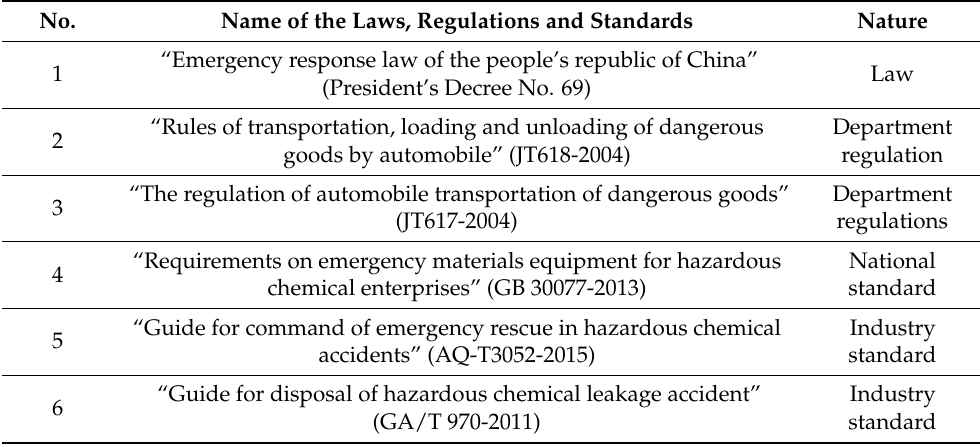
Table 1. Laws, regulations and standards.